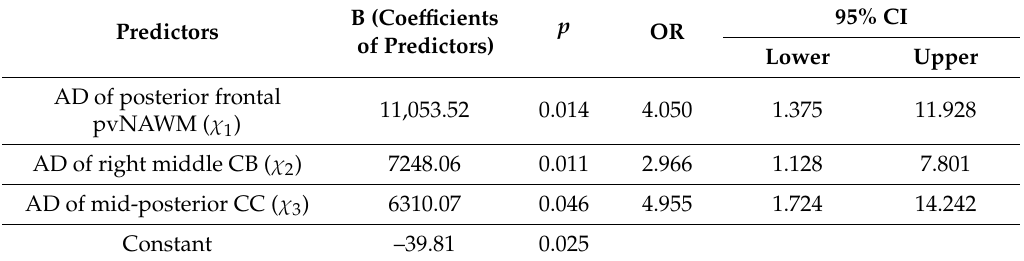
Table 4. Predictors of cognitive impairment (CI) severity (binary logistic regression, p < 0.001).